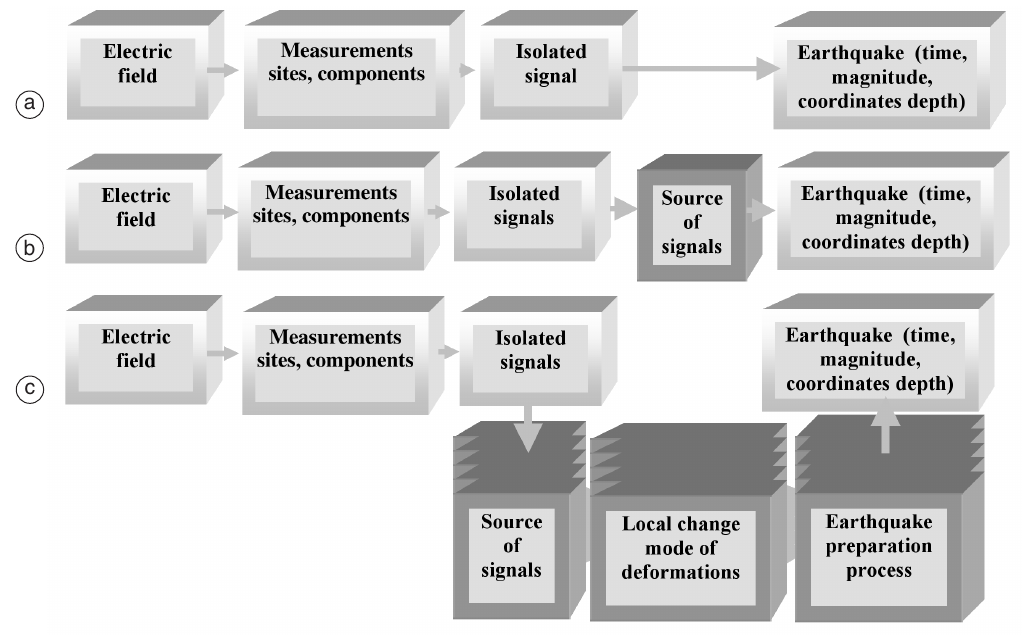
Fig. 11a-c. a) Standard and (b) new proposed empirical schemes of the forecast. c) The so-called theoretical scheme is also presented in the figure (see